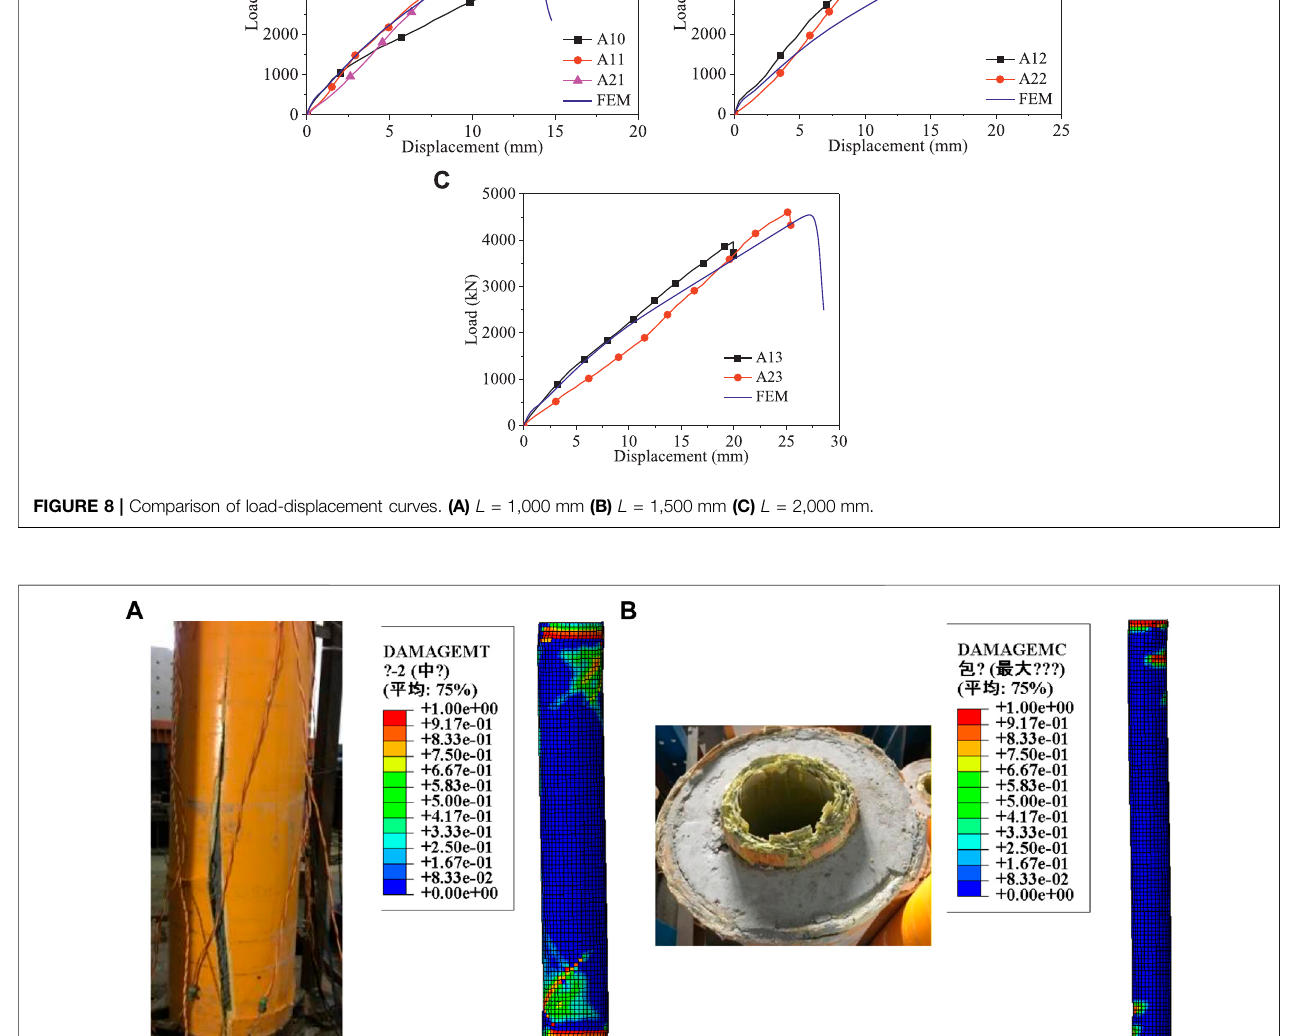
Frontiers in Built Environment |